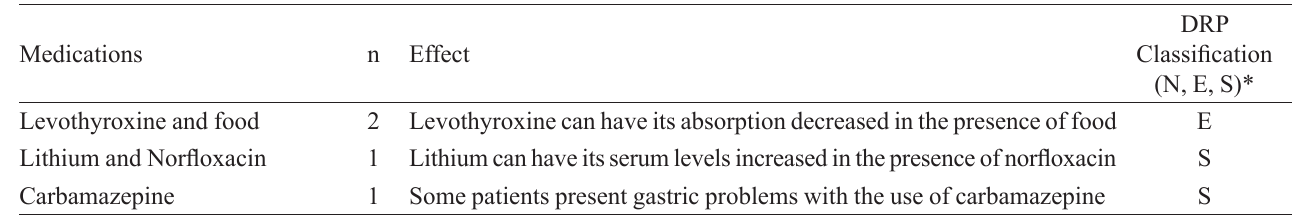
TABLE II – Risk for DRP associated to occurrence of drug interactions